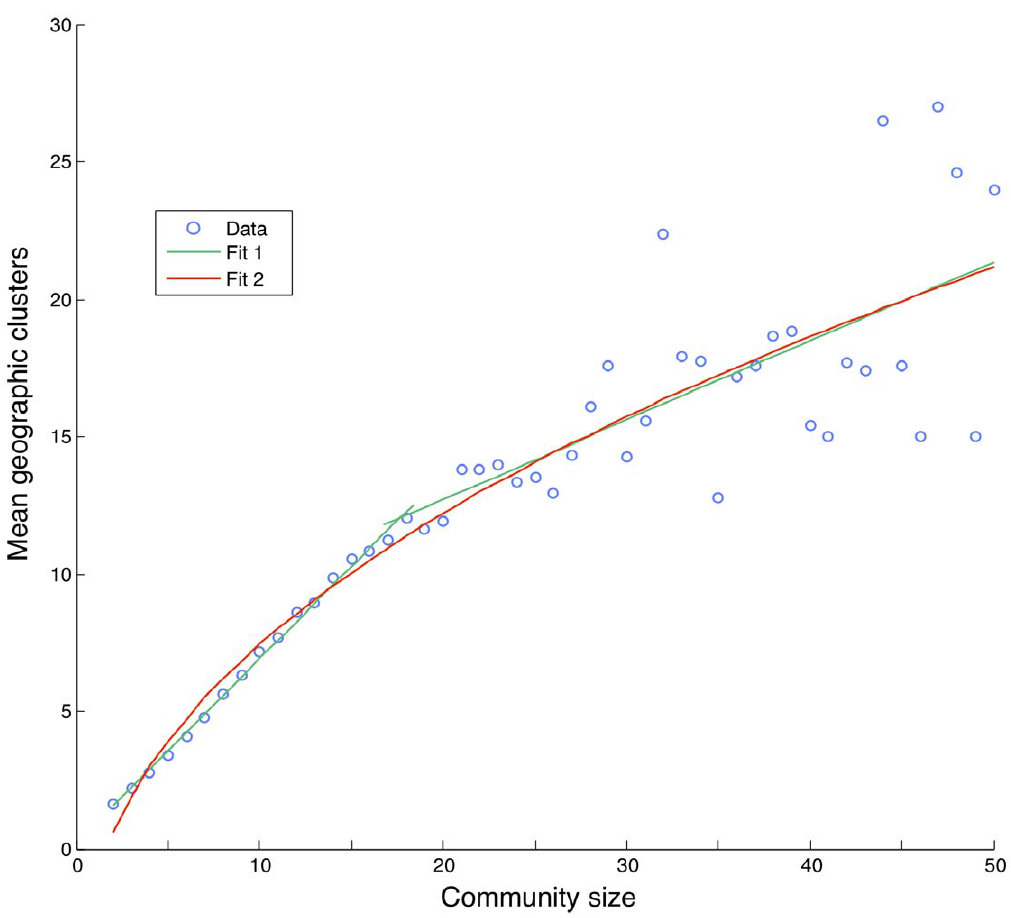
Figure 5. The average number of spatial clusters for empirical data, versus topological (network) community size. Clusters are detected using the k -means algorithm with the Akaike Information Criterion. We fit two models to data. First, a linear model y ~ a 1 z a 2 x was fit in two parts, shown in green, as well as a non-linear model y ~ b 1 z b 2 x b 3 , shown in red. We obtained the values a 2 ~ 0 : 67 for the first slope and a 2 ~ 0 : 29 for the second slope of the linear fits, and b 3 ~ 0 : 43 for the exponent of the non-linear model, implying approximately square-root behavior.